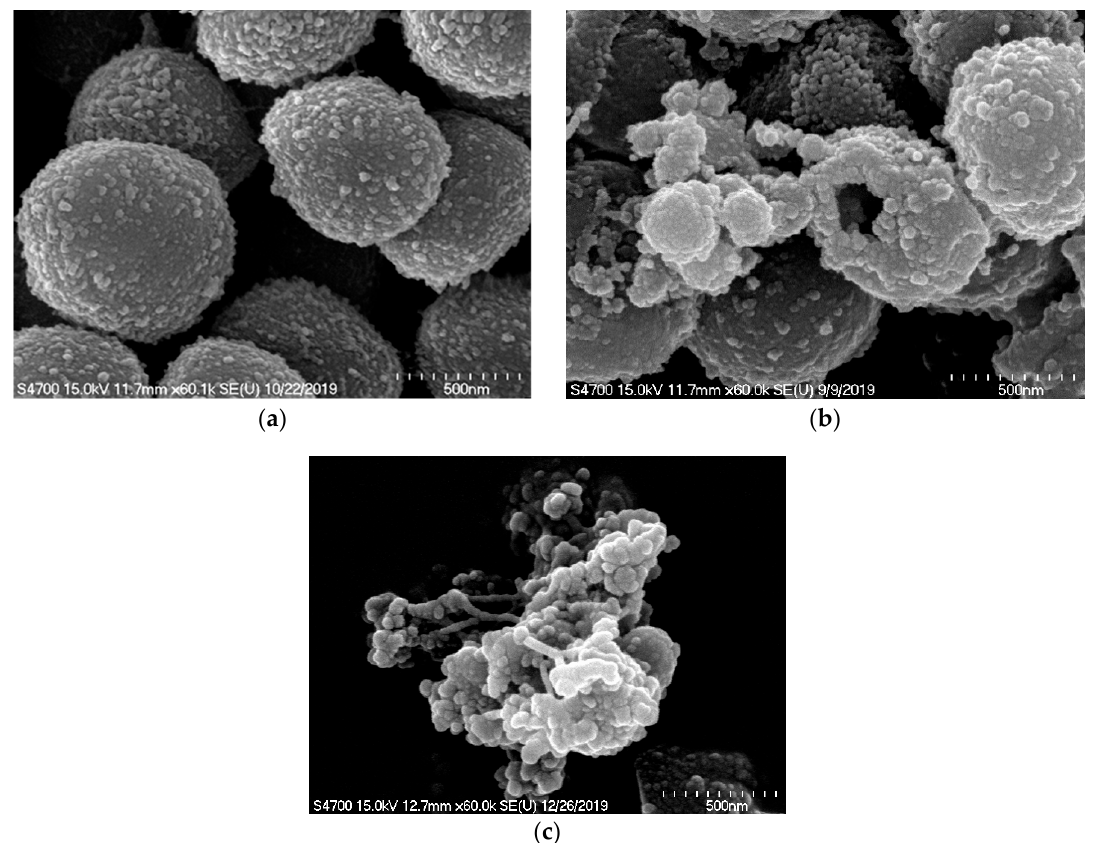
Figure 3. Scanning electron microscopy analysis of Staphylococcus epidermidis irradiated with blue light in the presence of 1 ppm compound 11 . (×60,000) The cell wall surface of S. epidermidis was severely damaged after the treatment. ( a ) Before irradiation with blue light, ( b ) Irradiation with blue light for 1 min, and ( c ) Irradiation with blue light for 5 min.